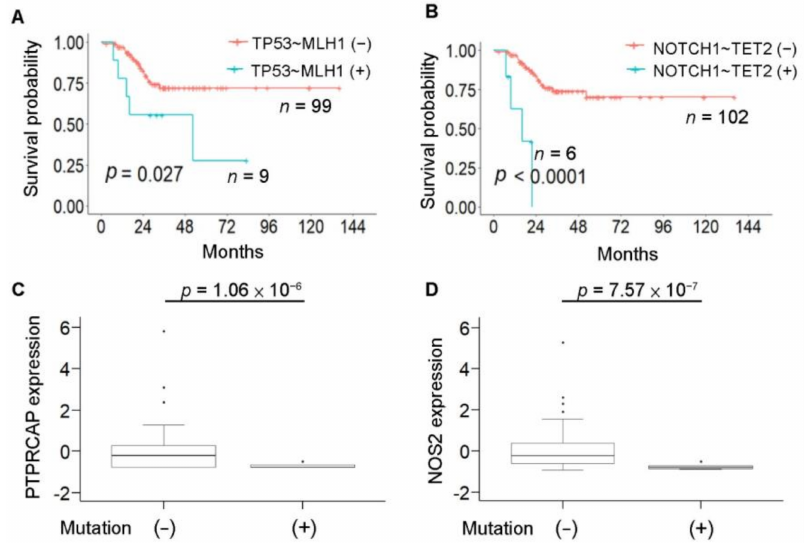
Figure 7. Hypermutation-associated sequential mutations impact survival. ( A ) Survival plot of TP53~MLH1 hypermutation-associated sequential mutations in CRC patients. Patients without TP53~MLH1 sequential mutations ( n = 99) exhibited a better clinical outcome than patients with this set of mutations. p -value = 0.027 according to the log-rank test. ( B ) Survival plot of NOTCH1 ~ TET2 hypermutation-associated sequential mutations in CRC patients. Patients without NOTCH1 ~ TET2 sequential mutations ( n = 102) exhibit a better clinical outcome than patients with this set of mutations. p -value < 0.05 by the log-rank test. ( C ) Boxplot of NOTCH1 ~ TET2 sequential mutations associated with immune gene expression with a p -value < 0.05. Patients with NOTCH1 ~ TET2 sequential muta- tions have reduced PTPRCAP expression compared to patients without this set of mutations. p -values were calculated by a t -test with Bonferroni correction. ( D ) Patients with NOTCH1 ~ TET2 sequential mutations exhibit reduced NOS2 expression compared to patients without this set of